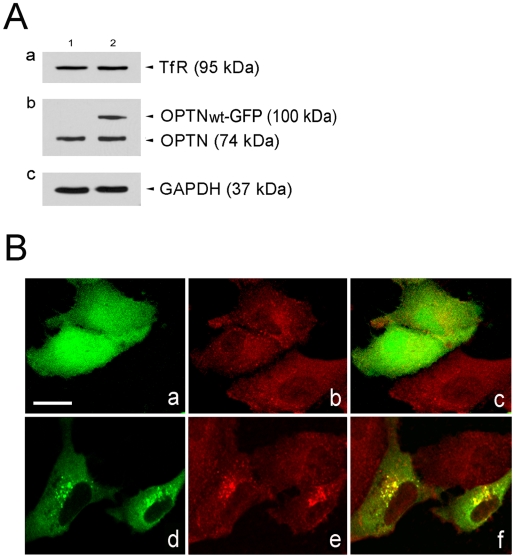
Effects of optineurin overexpression on the total level and distribution of the endogenous TfR in RPE cells.(A )Lysates (50 µg total protein) from cells transfected with pEGFP-N1 (lane 1) or pOPTNWT-GFP (lane 2) were immunoblotted with anti-TfR (Aa), anti-optineurin (OPTN) (Ab), and anti-GAPDH (Ac) antibodies. The expression level of 95-kDa TfR was not reduced by OPTNWT-GFP overexpression. Anti-OPTN detected the 74-kDa endogenous OPTN band in both lanes and a 100-kDa OPTNWT-GFP band in lane 2. Anti-GAPDH that detected a 37-kDa band, was used to control protein loading. (B) Distribution of TfR in GFP- and OPTNWT-GFP-expressing cells. RPE cells transfected with pEGFP-N1 (Ba-Bc, green) and pOPTNWT-GFP (Bd-Bf, green) were immunostained with anti-TfR (Bb, Bc, Be, Bf, red). Merged images are shown in Bc and Bf. Colocalization between OPTNWT-GFP and TfR is seen in yellow (Bf).